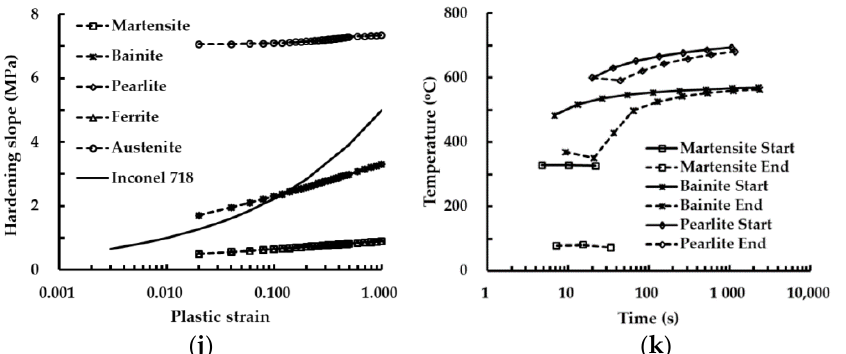
Figure 4. Thermal and mechanical properties of Inconel 718 and AISI 1045 [34,38]: ( a ) thermal diffusivity; ( b ) thermal strain; ( c ) elastic modulus; ( d ) Poisson’s ratio; ( e ) yield strength; ( f ) hardening slope—plastic strain curve (room temperature); ( g ) hardening slope—plastic strain curve (temperature = 200 °C); ( h ) hardening slope—plastic strain curve (temperature = 400 °C); (i) hardening slope—plastic strain curve (temperature = 800 °C); ( j ) hardening slope—plastic strain curve (temperature = 1200 °C); ( k ) continuous cooling transformation (CCT) diagram of AISI 1045.